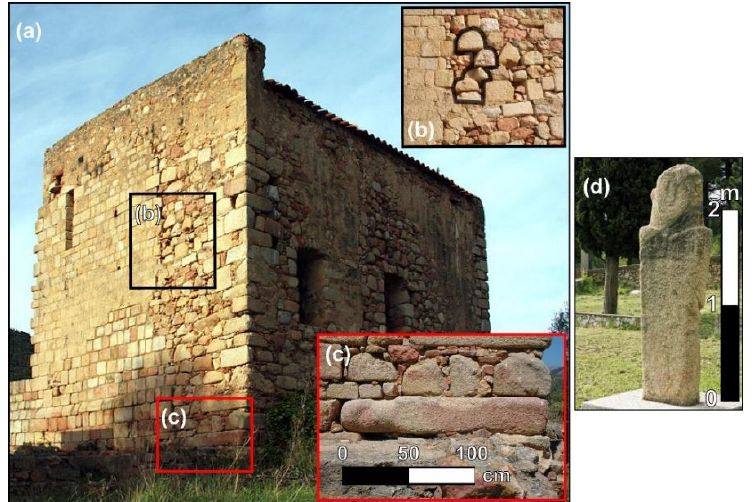
Figure 4. Archaeological evidence for the occupation of the Lower Sagone Valley. Sant’Appianu Cathedral view ( a ) with reuse of menhir statues as foundation stones ( b , c ); Menhir Statue of Apricciani ( d ).